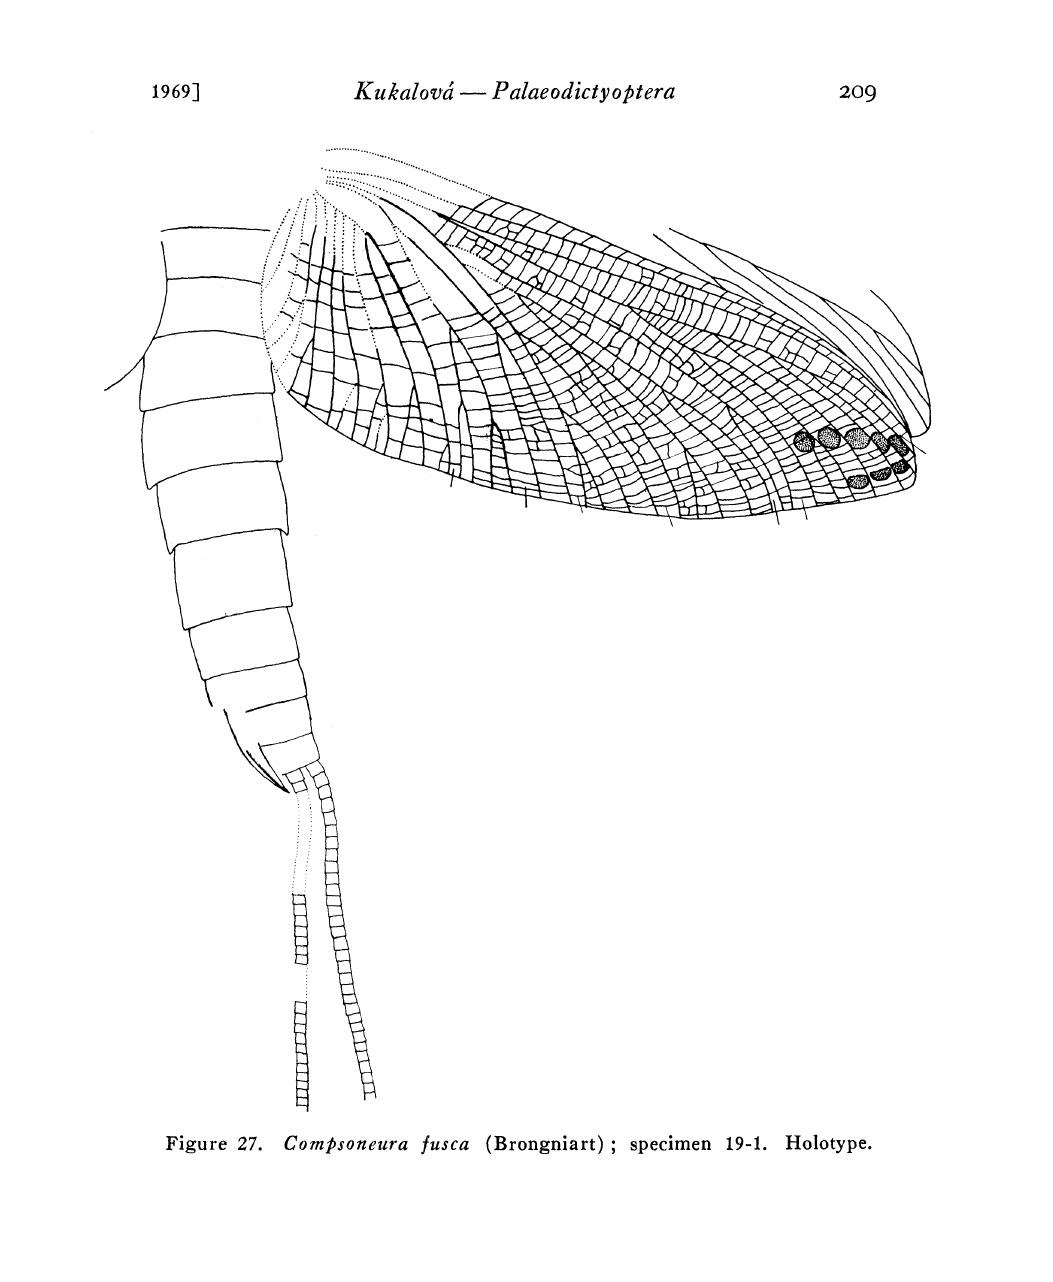
Figure 27. Comtsoneura fusca (Brongniart); specimen 19-1.